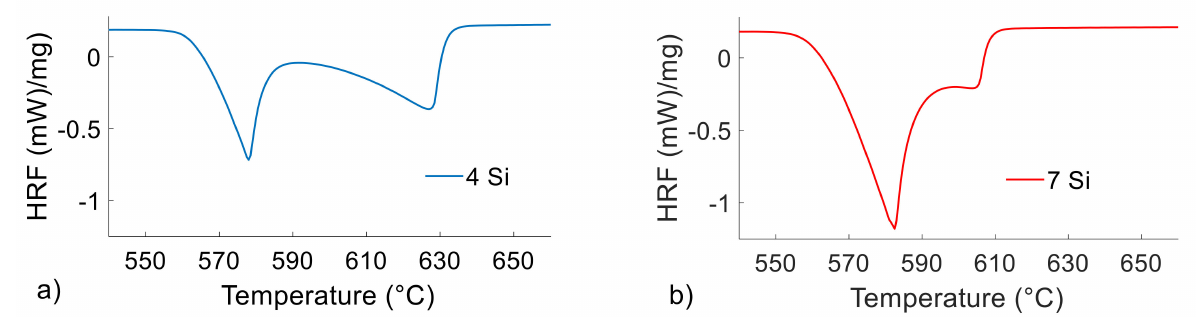
Figure 2. DSC heat flow rate ( y -axis) vs. temperature ( x -axis) curves during melting of the Al 4 Si 4 Zn ( a ) and Al 7 Si 4 Zn ( b ) alloys at 5 ◦ C/min with a DSC sample mass of 90 mg.